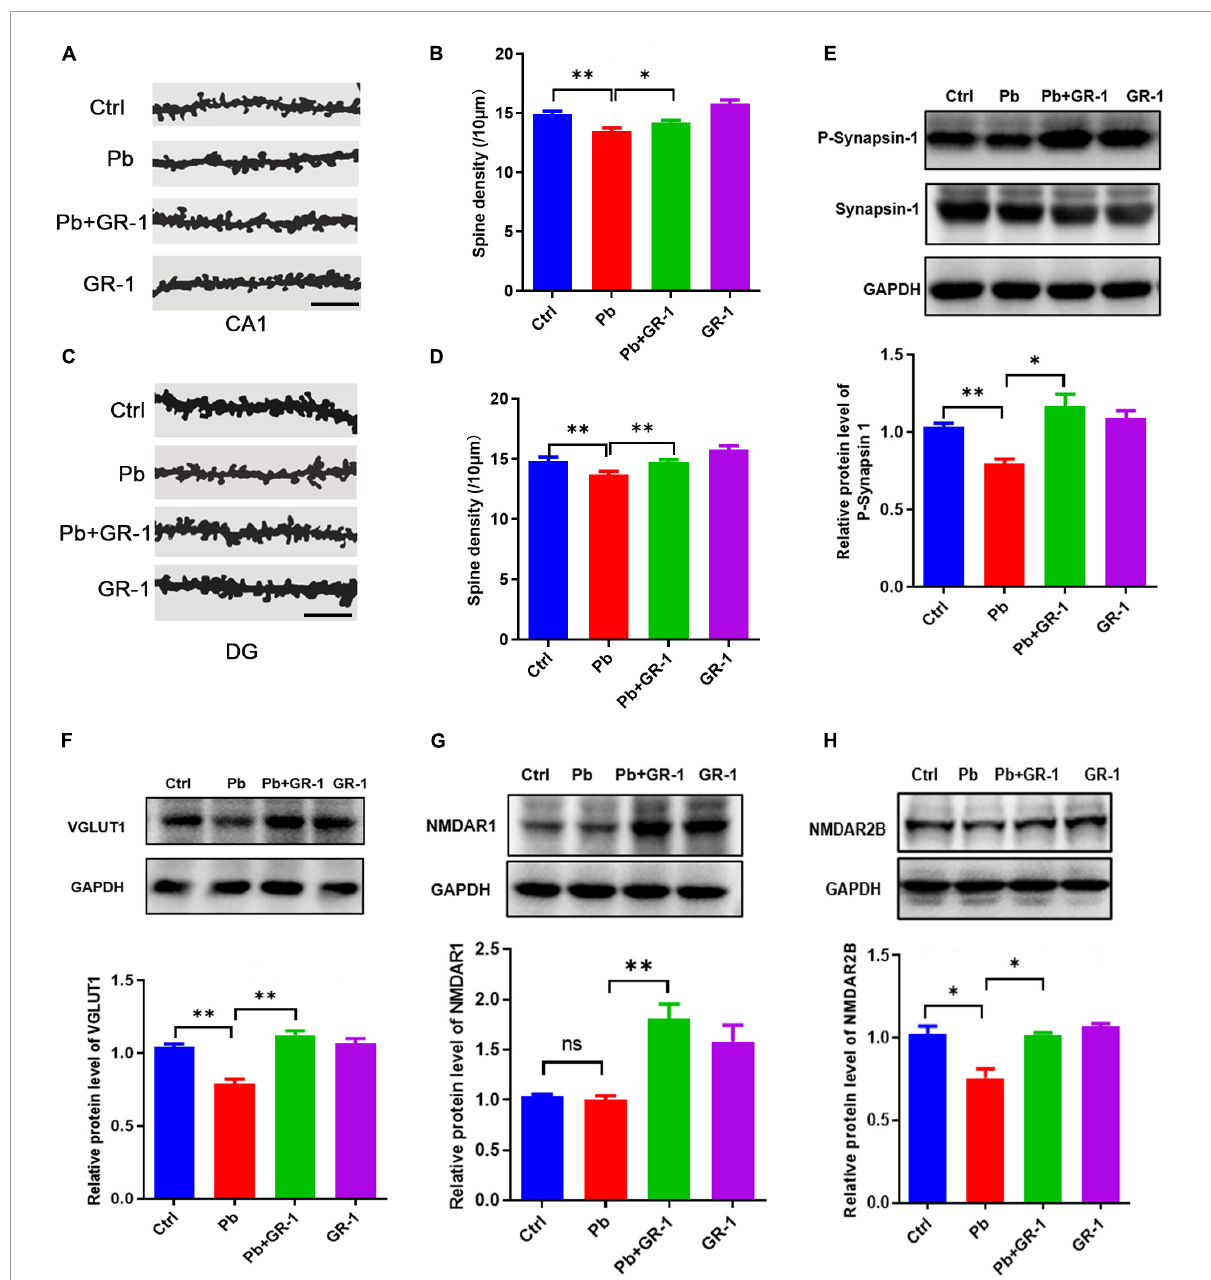
FIGURE2 Lactobacillus rhamnosus GR-1 supplementation rescued the morphological abnormalities of dendritic spines in the hippocampus. (A,B) Representative images (A) and quantification of spine densities are shown in the region of CA1 (B) . Scale bar = 10 µ m, n = 50. (C,D) Representative images (C) and quantification of spine densities are shown in the region of DG (D) . Scale bar = 10 µ m, n = 50. (E–H) Immunoblots and quantification of protein levels of P-synapsin-1, VGlut1, NMDAR1, and NMDAR2B upon the administration of Lactobacillus rhamnosus GR-1 of Pb-exposed rats. n = 3. Data are shown as mean ± SEM. ∗ p < 0.05, ∗∗ p <